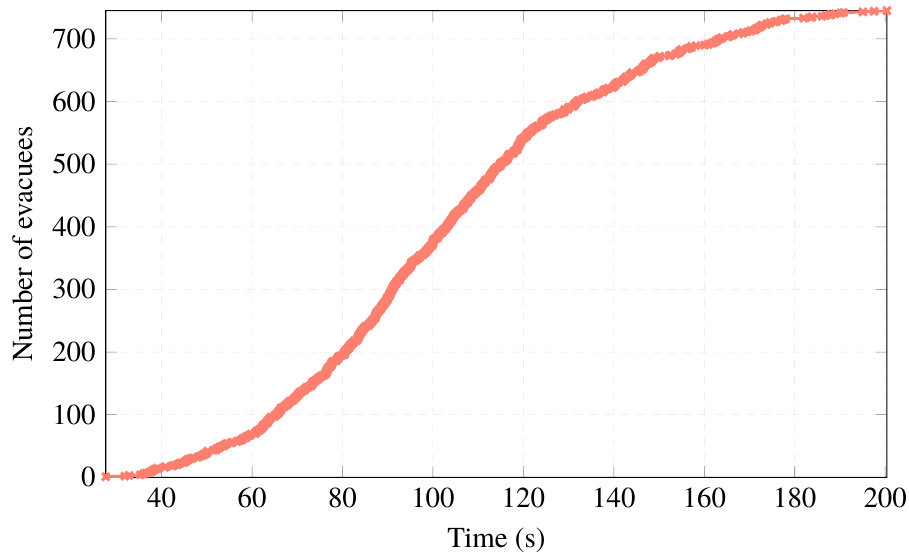
Figure 6. Dispersion diagram, abandonment time per number of evacuees (3 TW,